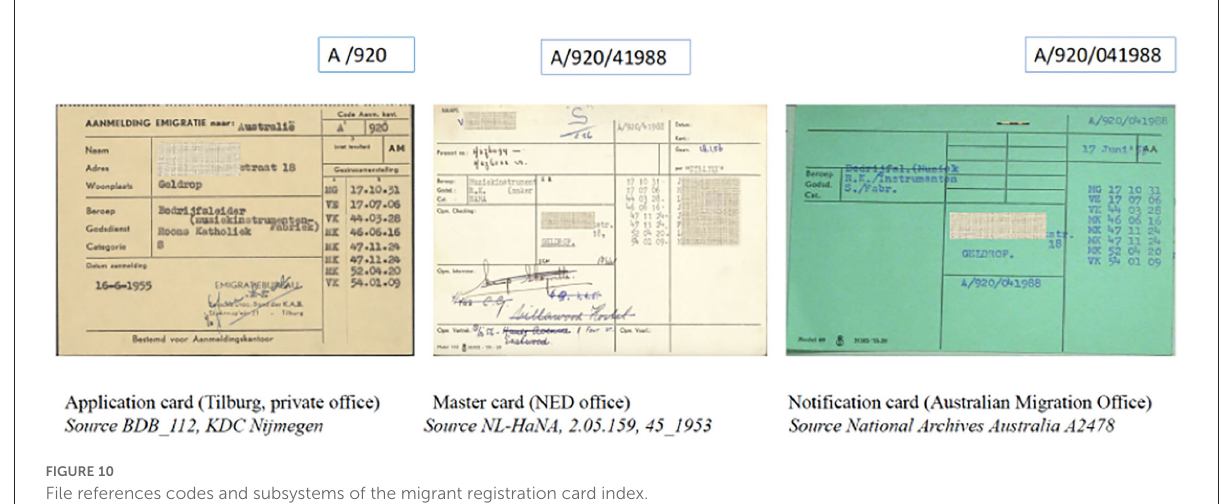
FIGURE10 File references codes and subsystems of the migrant registration card